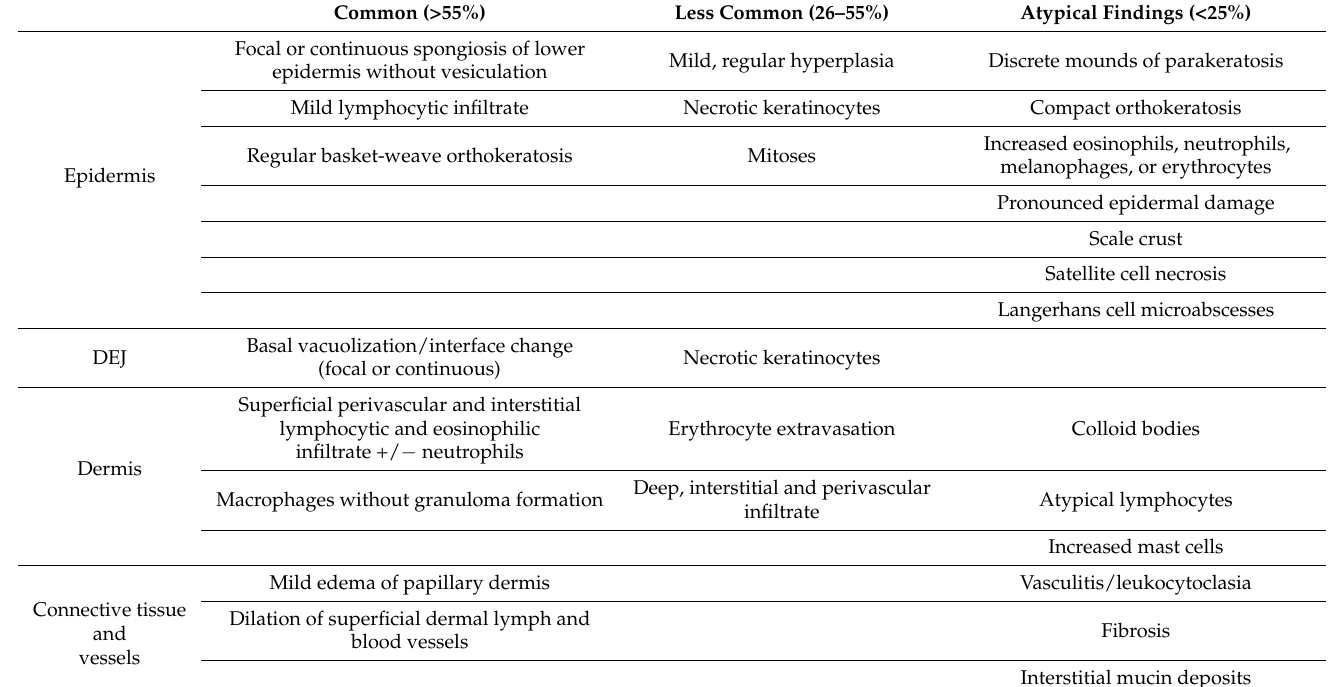
Table 2. Summary of histopathologic findings in MDE by